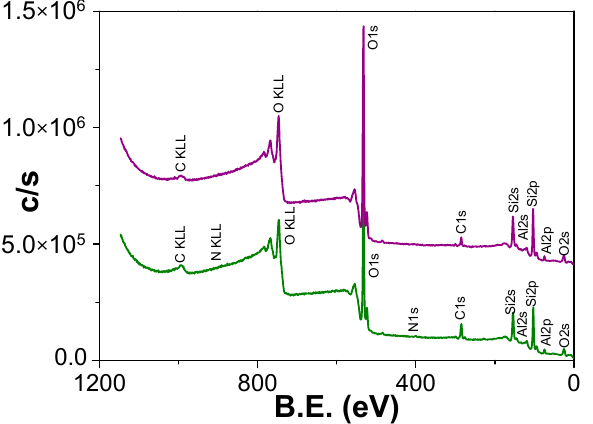
Figure 4. Survey XPS spectra of Ox+SiO 2 /APTES (green line) and Ox+SiO 2 /APTES/O 3 (purple line) samples.